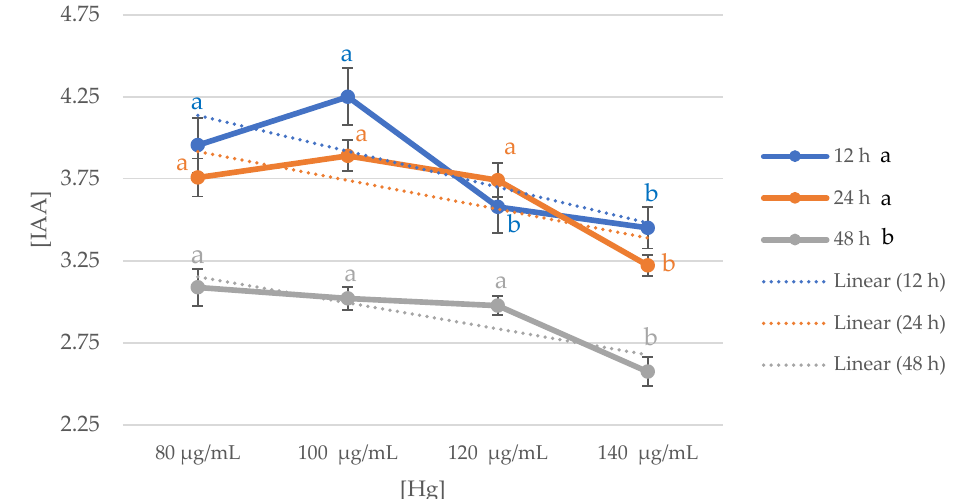
Figure 1. Average IAA production trend of the forty strains studied in relation to Hg concentrations at each of the measurement times. Letters a-b indicate the significance of p < 0.05, the black letters indicate significance differences among those grouped by hours; the blue letters indicate significance differences among the different concentrations of IAA measured at 12 h; orange letters indicate significance differences among different concentrations of IAA measured at 24 h; grey letters indicate significance differences among different concentrations of IAA measured at 48 h.